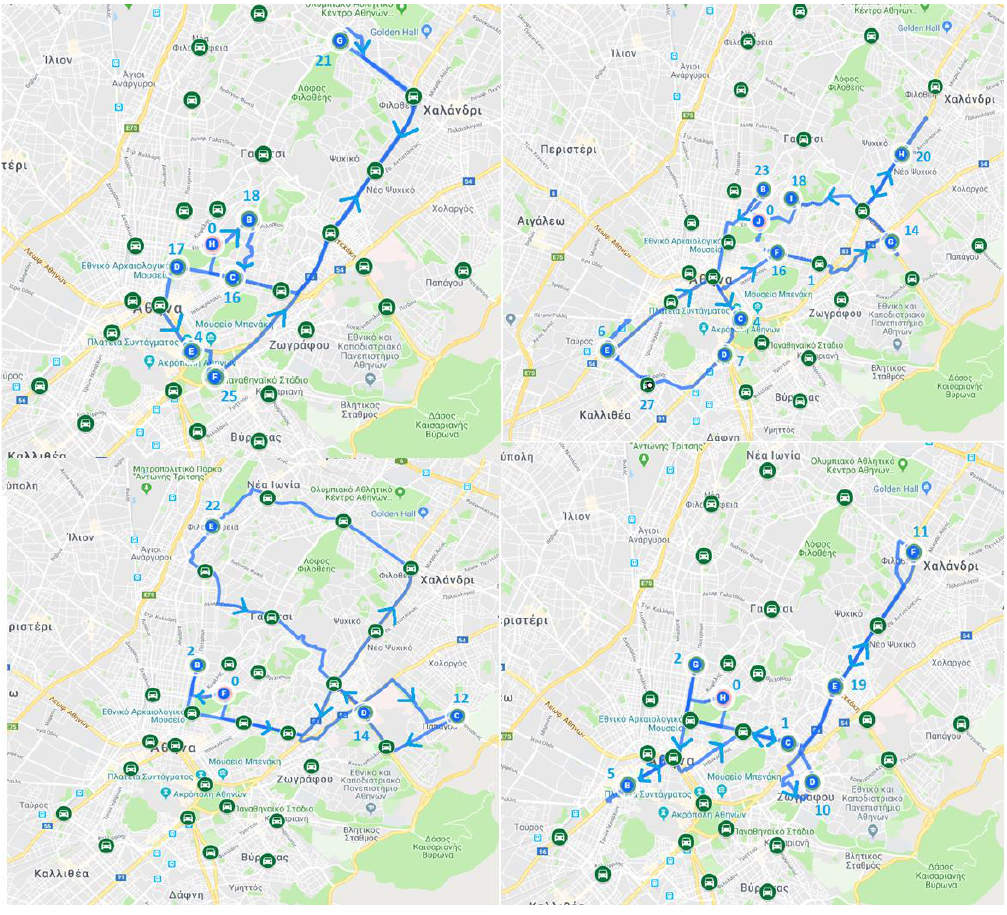
Figure 3. Routes for vehicles 1 ( top left ), 2 ( top right ), 3 ( bottom left ), 4 ( bottom right